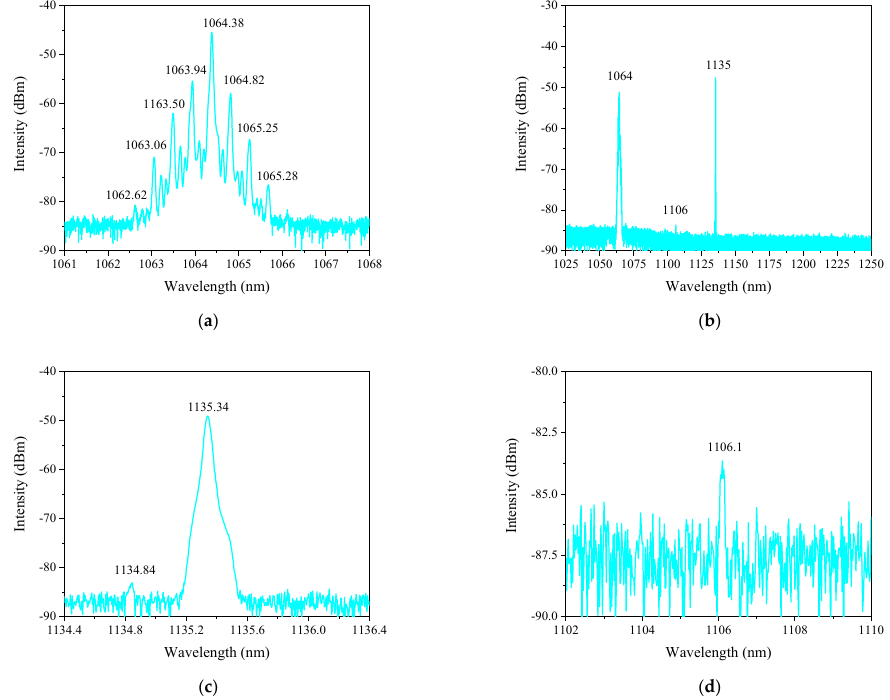
Figure 5. ( a ) The output spectrum of the pump source at the maximum output power when the pulse width of the pump laser is 2 ns and the repetition frequency is 20 MHz. ( b ) The total output spectrum of 1 μ m all-fiber FGRL in this case. ( c , d ) The fine spectrum of the first-order Stokes waves at 1135 nm and 1106 nm, respectively.